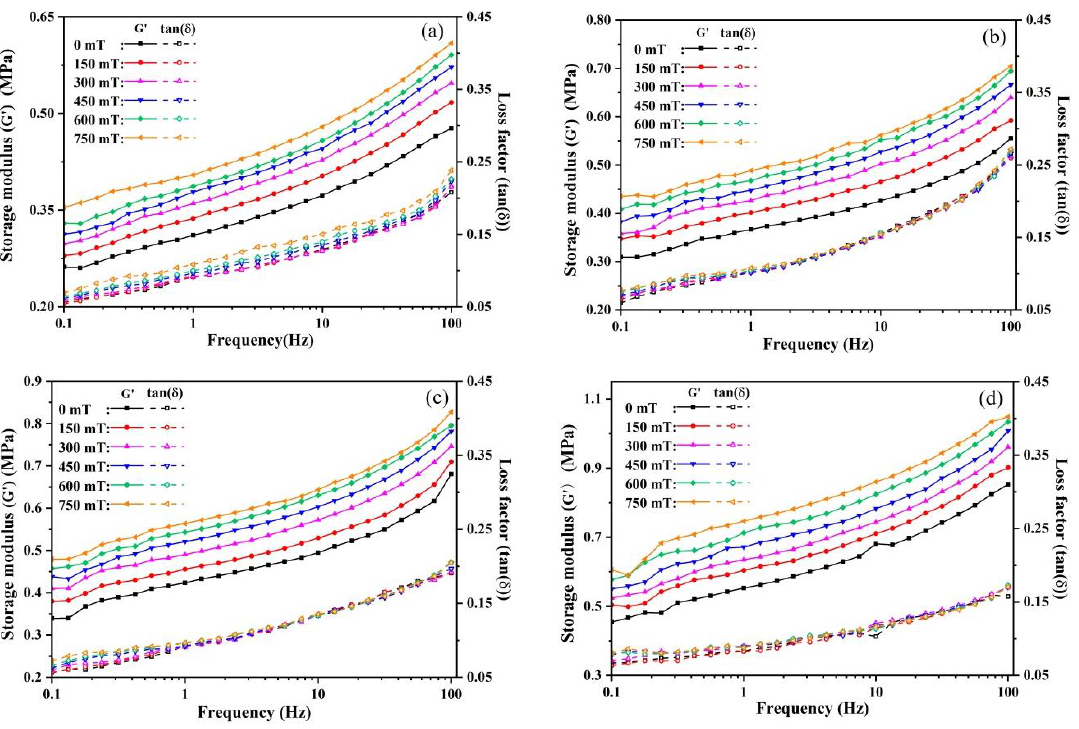
Figure 12. The plots of the storage modulus G’ and loss factor tan( δ ) versus test frequency of the MREs under various magnetic fields: ( a ) MRE-0; ( b ) MRE-1; ( c ) MRE-3; and ( d ) MRE-5.